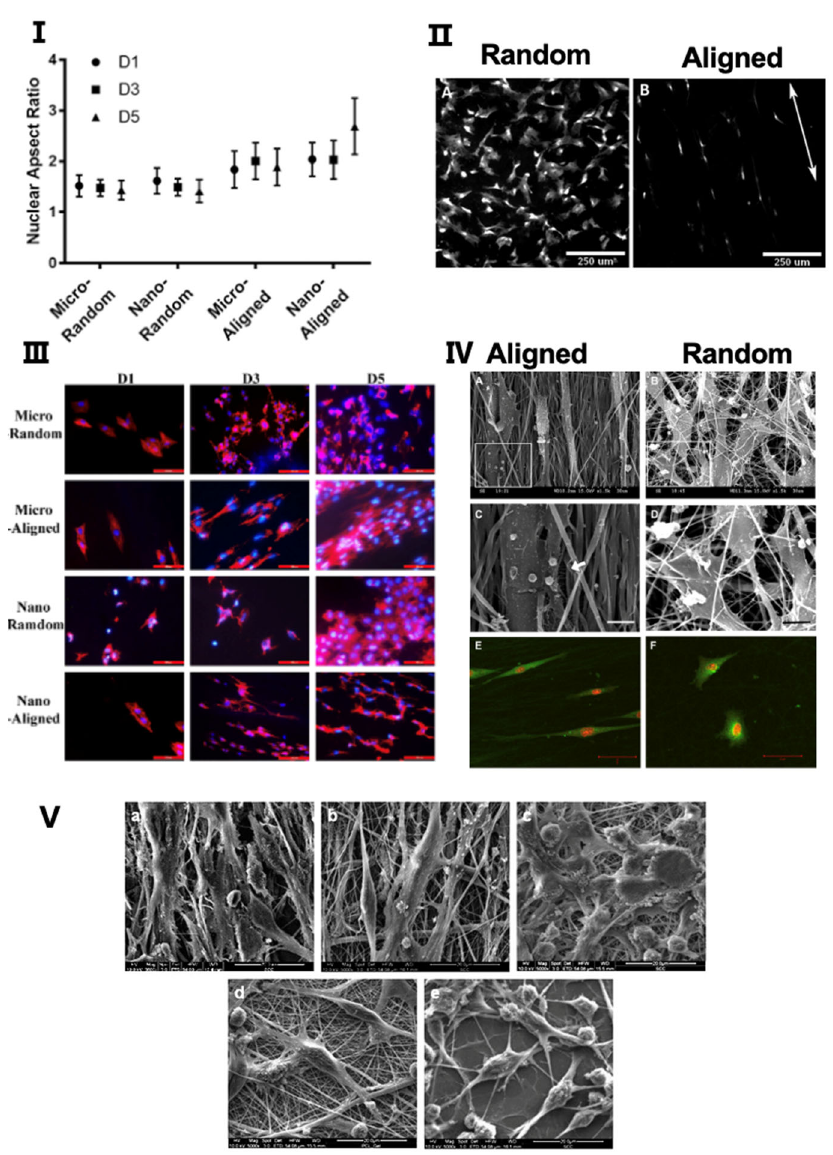
Figure 2. ( I ) Cell nuclei on aligned scaffolds had a higher aspect ratio as compared to nuclei on random scaffolds (Reproduced from [102], Elsevier Ltd., Amsterdam, The Netherlands). ( II ) GFP-expressing rat dermal fibroblasts cultured on random collagen scaffolds exhibited random distribution, while cells seeded on aligned scaffolds exhibited elongated shape and were aligned in the direction of the long axis of fibers (arrows indicate the orientation of the aligned scaffolds) (Reproduced from [104], American Chemical Society). ( III ) Cytoskeleton of HUVECs on different fibrous membranes on days 1, 3, and 5. Cytoskeletal F-actin (red) was shown at the cell periphery on randomly oriented nanoscale and microscale scaffolds, while cytoskeletal F-actin of cells were oriented parallel to the aligned nanoscale and microscale scaffolds (Reproduced from [102], Elsevier Ltd.). ( IV ) Morphological changes of tendon stem/progenitor cells grown on scaffolds. Here, B and F showed that cells on random scaffolds exhibited a stellate-patterned phenotype with randomly distributed features, while cells on aligned nanofibers (A,E) exhibited a classic fibroblast phenotype and are parallel to the fiber axis (Reproduced from [80], Elsevier Ltd.). ( V ) The SEM micrograph of Schwann cells on nanofiber scaffolds obtained after day 12 of cell culture. ( a , b ) showed that Schwann cells on oriented scaffolds were oriented along the fiber direction and aggregated around aligned fibers in a longitudinal manner, while ( c , d ) showed that cells grew in different directions on random fibers (Reproduced from [103], Elsevier